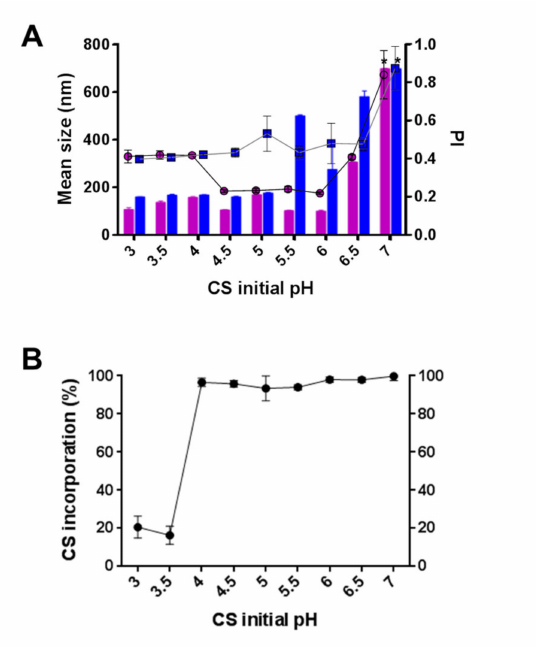
Figure 1. Effect of chitosan (CS) initial pH on the characteristics of empty and human phenylalanine hydroxylase (hPAH) loaded nanoparticles. ( A ) Mean size (bars) and polydispersity index (PI) (lines) of empty (pink circles) and hPAH loaded nanoparticles (blue squares) as monitored by dynamic light scattering (DLS); * indicates aggregated samples. ( B ) CS consumption during empty particle formation as measured by cibacron brilliant red 3B-A staining. Values represent mean ± S.D. ( n = 3). Nanoparticles were obtained at a final concentration of CS at 833 µ g/mL, tripolyphosphate (TPP) at 333 µ g/mL and hPAH at 55 µ g/mL (2.5:1 CS:TPP and 15:1 CS:hPAH w : w ratio). For further details see Materials and